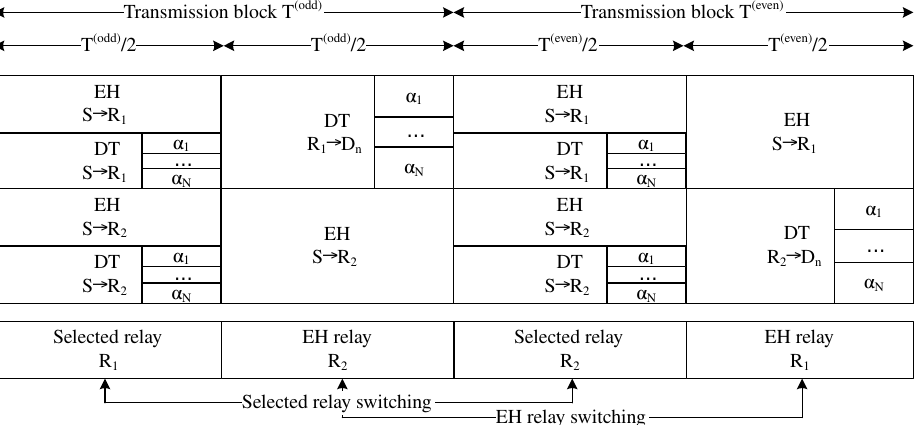
Figure 2. Diagram of two transmission